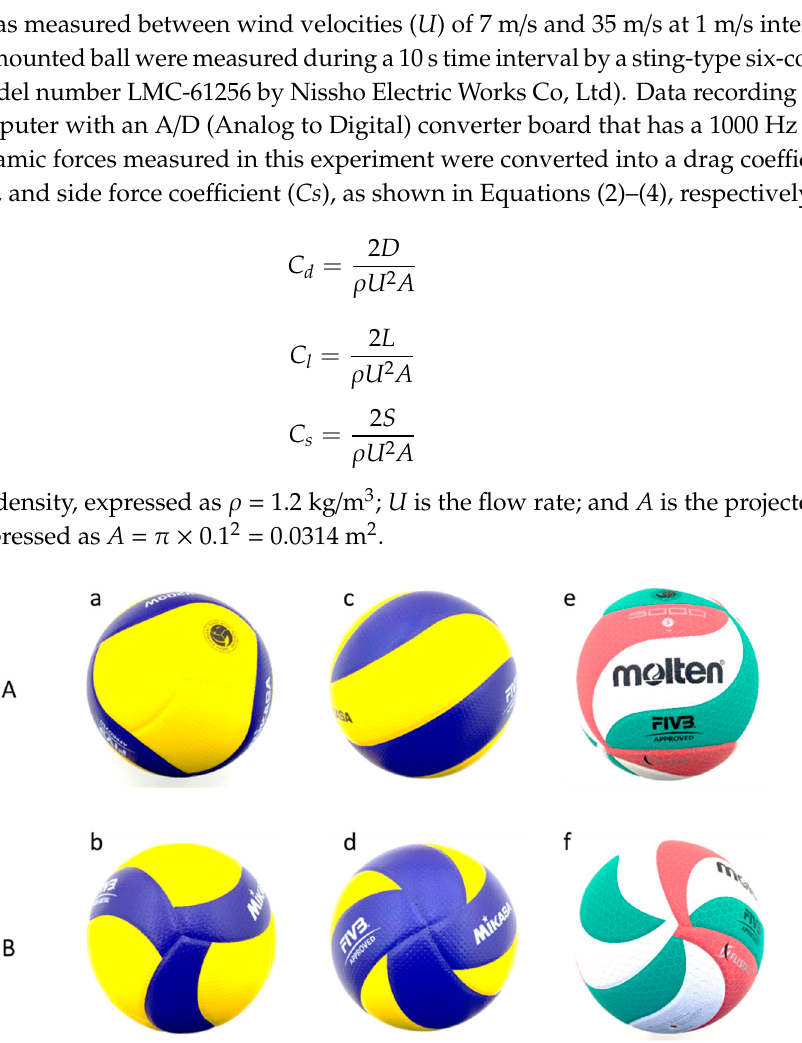
Figure 2. Volleyballs used in the experiment and their panel orientation settings. In this figure, ( a , b ) represent the Face A and B orientation of the new Mikasa volleyball (V200W), respectively; ( c , d ) represent the Face A and B orientations of the old Mikasa volleyball (MVA200), respectively; and ( e , f ) represent the Face A and B orientation of the old Molten volleyball (V5M5000), respectively.